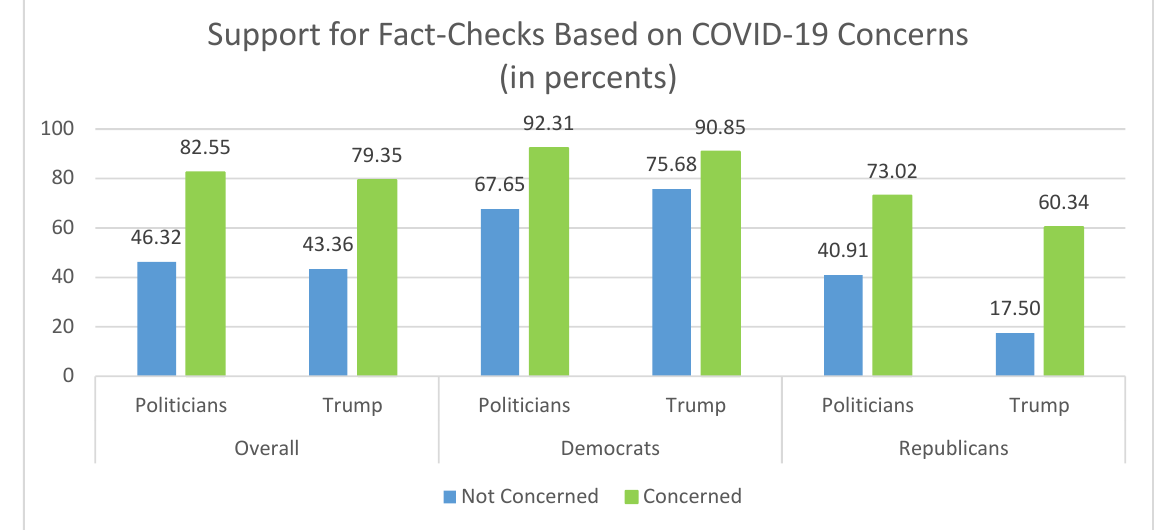
Figure 2. Support for fact-checks based on level of concern on contracting